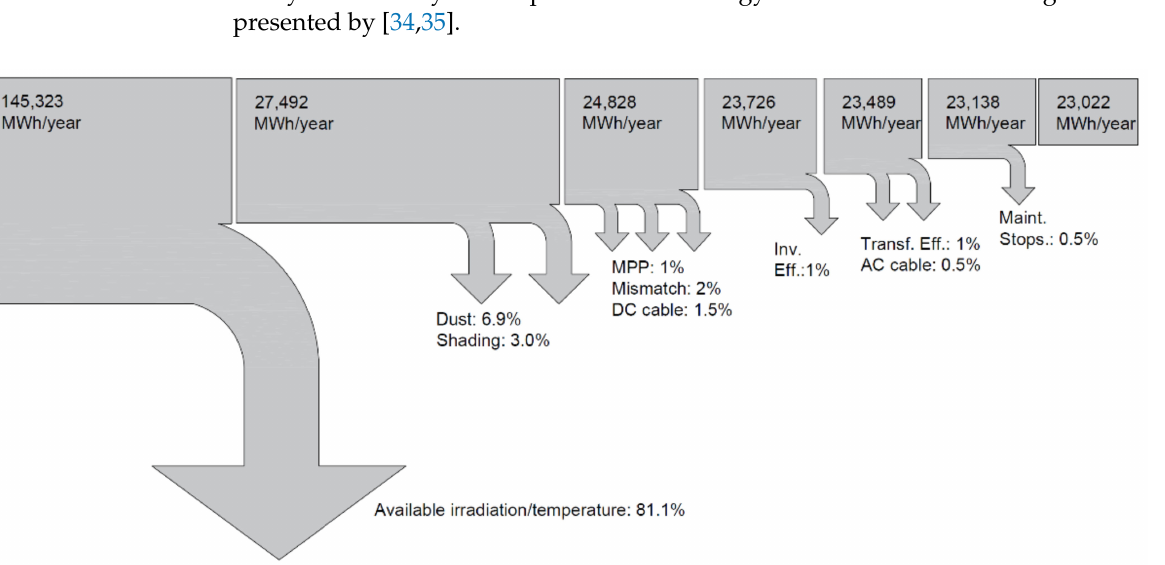
Figure 3. Sankey diagram of energy flows associated with the photovoltaic solar generation